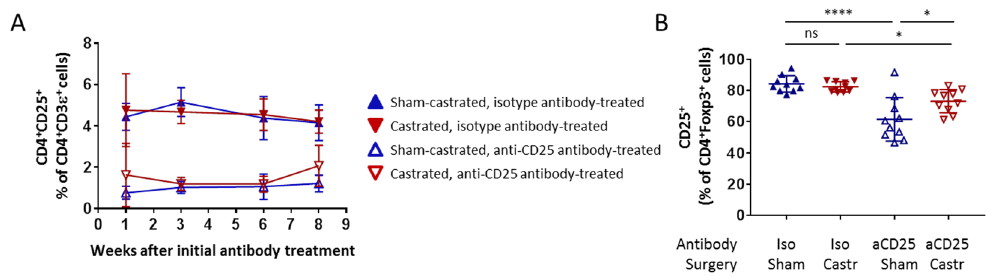
Figure A1. Treg depletion was comparable in castrated and sham-castrated mice. ( A ) Castrated (red) and sham-castrated (blue) mice in Figure 1 were treated with anti-CD25 monoclonal antibody (clone PC61; open symbols) to transiently deplete Tregs or isotype control antibody (closed symbols) as described in Figure 1. At 1, 3, 6, and 8 weeks following initial monoclonal antibody treatment, peripheral blood mononuclear cells were analyzed by flow cytometry to quantify the degree of Treg-depletion. Graph depicts CD4 + CD25 + T cells as percentage of CD4 T cells (i.e., CD4 + CD3e + ) at time points as indicated. Symbols represent means, error bars are standard deviations. n = 10 mice per group. For these studies, a different clone of anti-CD25 monoclonal antibody (7D4) than that used for Treg-depletion was used for flow cytometry analyses. Repeated measures two-way ANOVA demonstrated significance based on mouse group ( p < 0.0001) but not time ( p = 0.6834) and with a significant interaction between the two ( p =0.0238). Values for the anti-CD25 antibody-treated groups were significantly decreased at each time point compared to the isotype-treated antibody groups ( p <0.0001 for each comparison) based on Tukey’s multiple comparisons test, but no differences were significant when comparisons were made between castrated and sham-castrated groups treated with the same antibody (ie, anti-CD25-treated sham vs castrated OR isotype-treated sham vs castrated). Of note, the 8 week time point (2 weeks prior to take-down) suggested a trend towards an